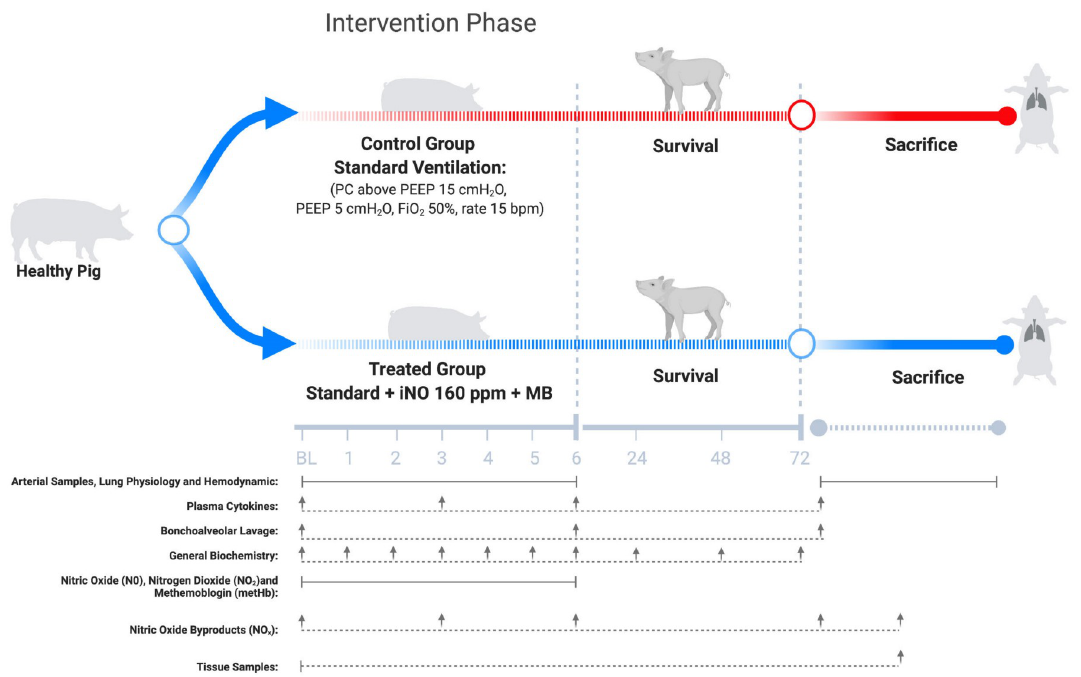
Fig 1. Study design. Ten animals were randomly allocated into one of the following groups: Control group (red line, n = 5), which consisted of 6h of standard ventilation; or treatment group (blue line, n = 5), which consisted of 6h of standard ventilation + 160 ppm of iNO + MB 1mg/Kg administered in bolus when metHb was 6% or higher. After the intervention phase, all animals were weaned, extubated and followed clinically for three days. On day 3, animals were sacrificed by exsanguination. Samples collection and assessments were performed during the experiments detailed in the lower part of the Fig 1. Definition of abbreviations: BL = baseline, ppm = parts per million, MB = methylene blue, iNO = inhaled nitric oxide, metHb = methemoglobin, NO 2 = nitrogen dioxide and NOx = nitric oxide byproducts, PC = pressure control, PEEP = positive end-expiratory pressure, bpm = beats per